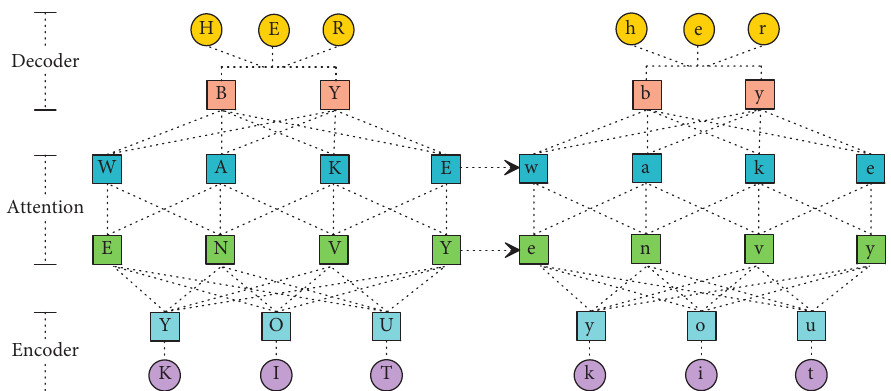
Figure 2: Translation model English grammar error correction